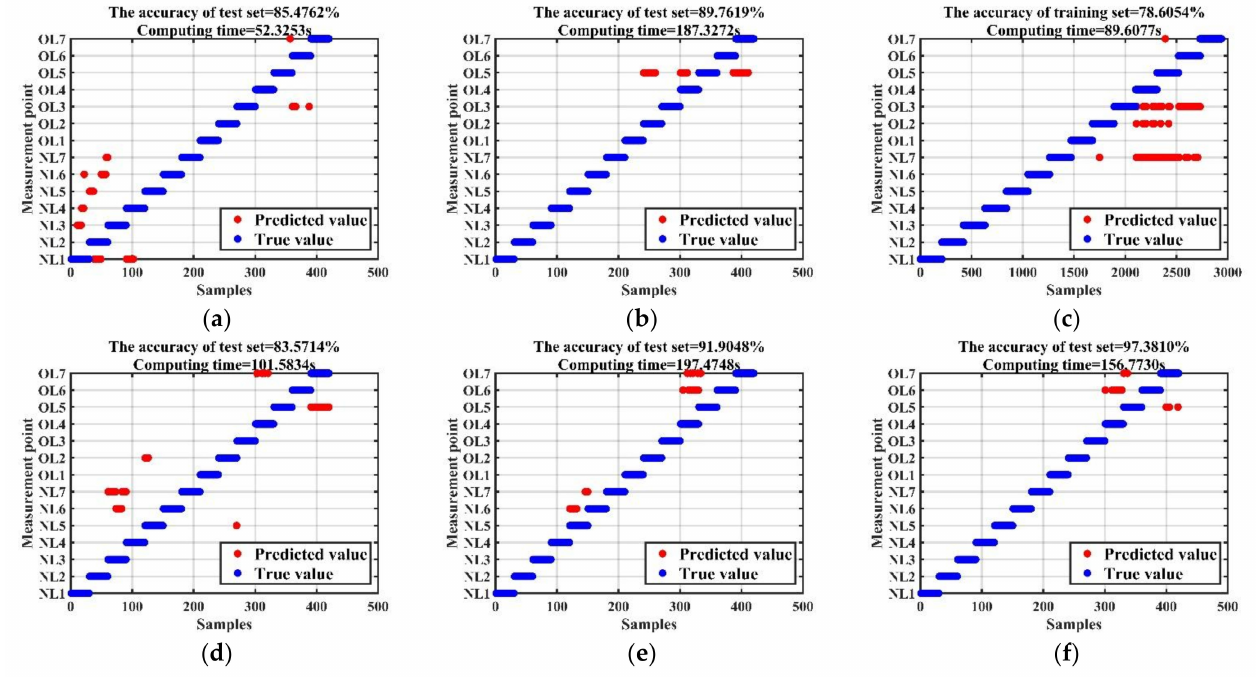
Figure 10. Experimental results of the test